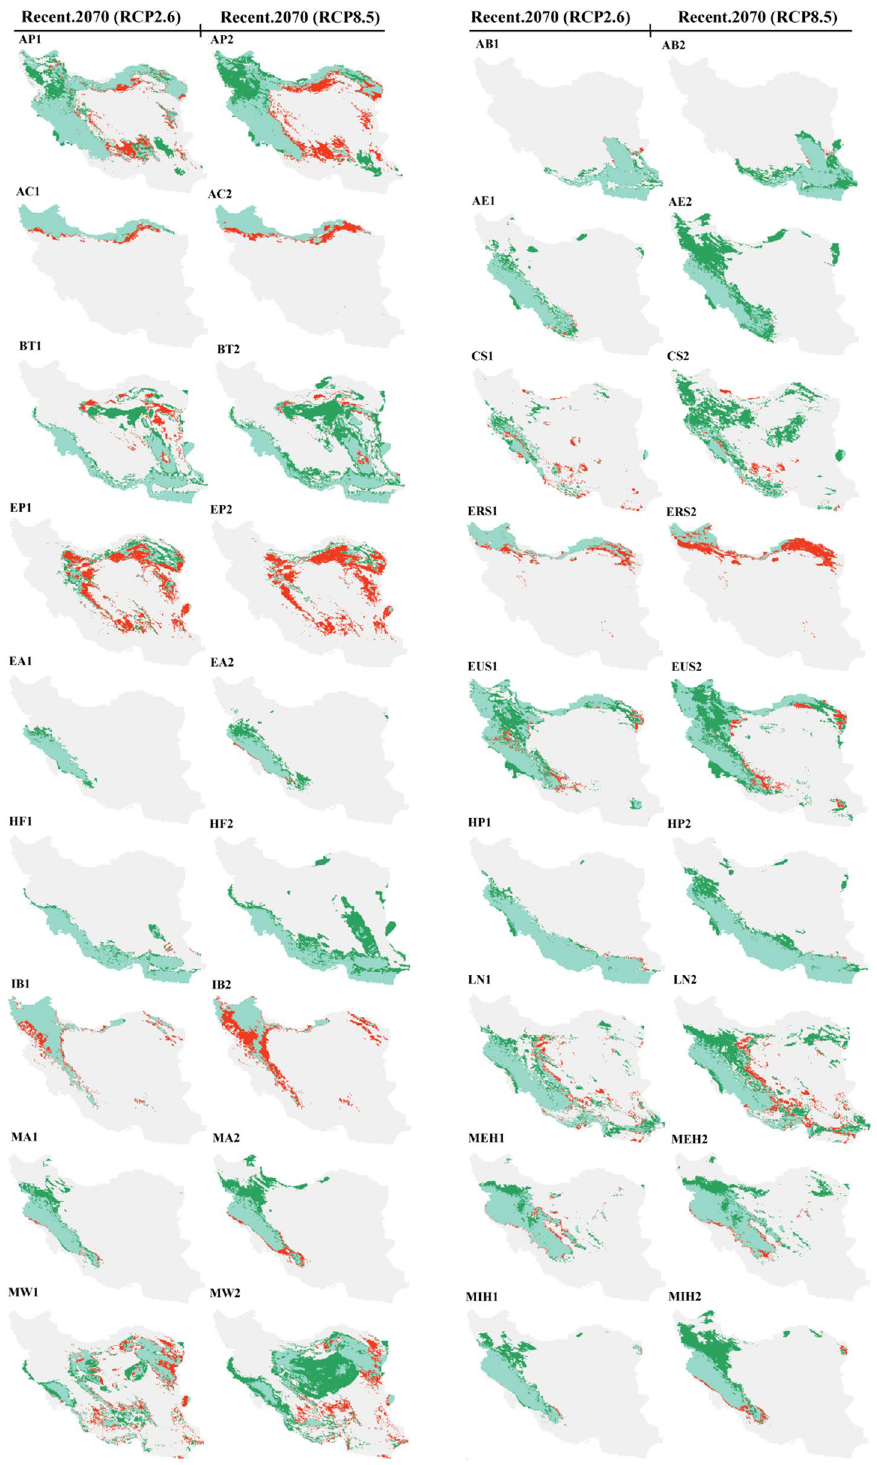
Figure 3. Species range change of 30 species of lizards in recently suitable habitats (gain/loss) by 2070 under optimistic (RCP2.6) and pessimistic (RCP8.5) scenarios in Iran. (AP) Ablepharus pannonicus ; (AB) Acanthodactylus blanfordii ; (AC) Anguis colchica ; (AE) Asaccus elisae, (BT ) Bunopus tuberculatus ; (CS) Cyrtopodion scabrum ; (EP) Eremias persica ; (ERS) Eremias strauchi; (EA) Eublepharis angramainyu ; (EUS) Eumeces schneideri ; (HF) Hemidactylus flaviviridis ; (HP) Hemidactylus persicus ; (IB) Iranolacerta brandtii ; (LN) Laudakia nupta ; (MA) Mediodactylus aspratilis ; Mediodactylus heterocercum (MEH); (MW) Mesalina watsonana ; (MIH) Microgecko helenae ; (ML) Microgecko latifi ; (MP) Microgecko persicus ; (OE) Ophisops elegans ; (PC) Paralaudakia caucasia ; (PM) Phrynocephalus maculatus ; (PP) Phrynocephalus persicus ; (PS) Phrynocephalus scutellatus ; (TC) Tenuidactylus caspius ; (TP) Timon princeps ; (TS) Trachylepis septemtaeniata ; (TA) Trapelus agilis ; (TR) Trapelus ruderatus . Maps were generated using R (v 4.2.0) (https:// cran.r- proje ct.